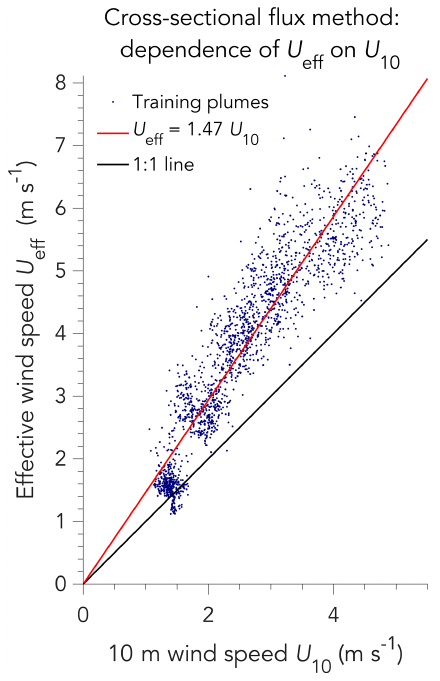
Figure 7. Relationship between the effective and local 10m wind speeds in the cross-sectional flux method, characterized with LES training plumes assuming 1% instrument precision. Each point rep- resents a different LES plume pseudo-observation from the training set. The red line fits the data to a linear function, excluding the low- est wind speed population ( U 10 < 2ms − 1 and U eff < 2ms − 1 ) . See text for corresponding results with 3% and 5% instrument preci- sion. U eff for the cross-sectional flux method is different than for the IME method (Fig.